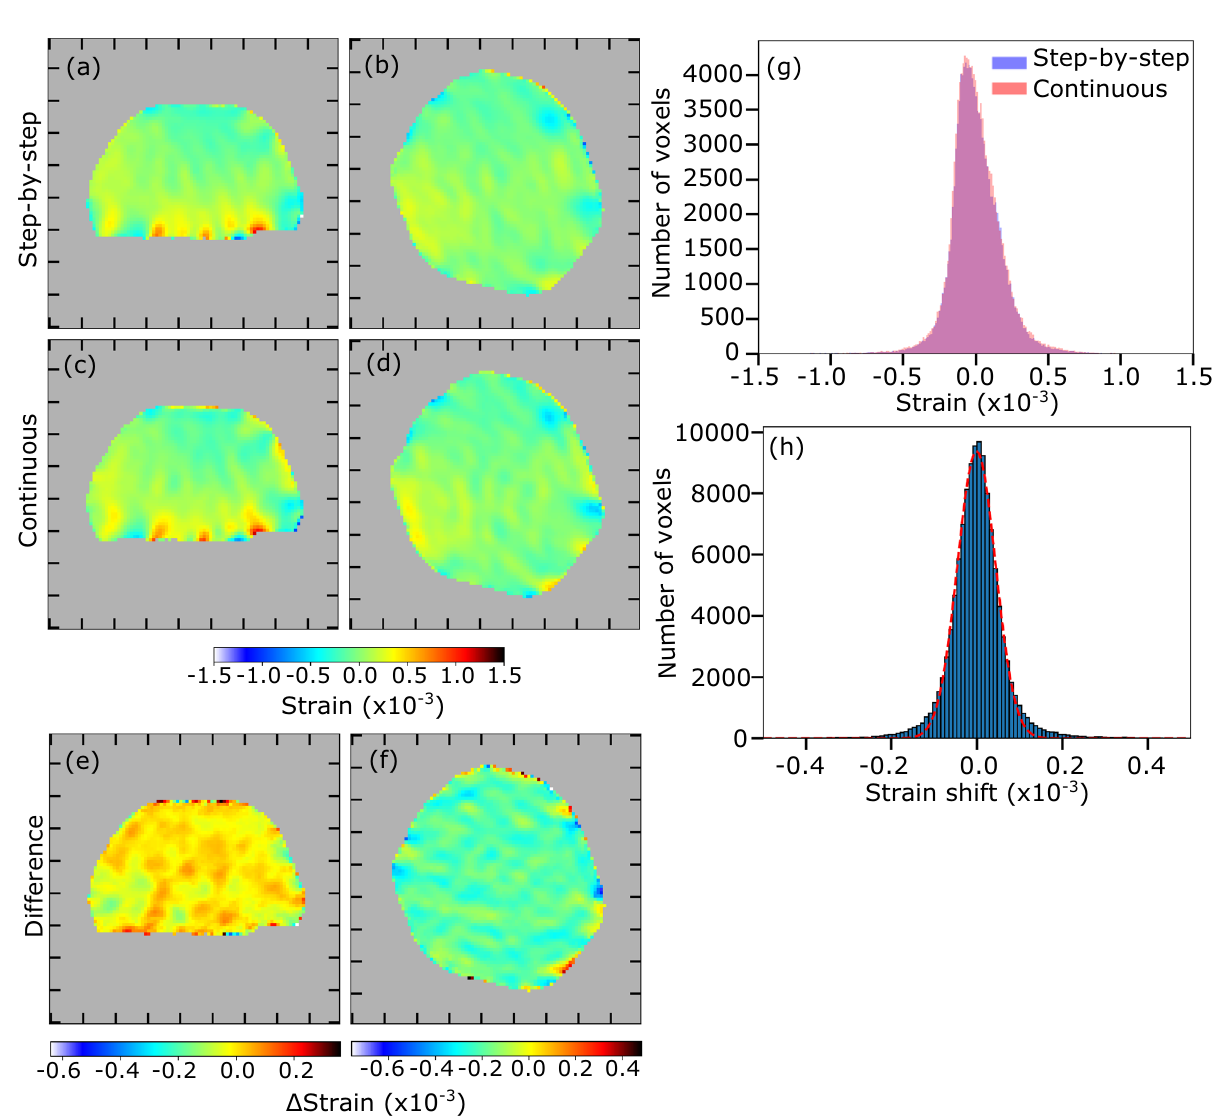
Figure 4. Quantitative comparison of retrieved strains. ( a , b ) Central slice of the reconstructed strain in yz and xy planes for the step-by-step scan, drawn at 30% of the reconstructed modulus. ( c , d ) Central slice of the reconstructed strain in yz and xy planes for the continuous scan, drawn at 30% of the reconstructed modulus. ( e , f ) Central slice of the difference of the reconstructed strains in yz and xy planes, drawn at 30% of the reconstructed modulus of the step-by-step scan. Ticks correspond to 100 nm. The colorbar in the difference maps reflects the full range of the slice only, not of the full crystal. ( g ) Histograms of the strain ( ε ¯ 111 ) reconstructed for both scanning methods. ( h ) Histogram of the strain difference between the two scanning methods on a voxel-by-voxel basis as well as its Gaussian